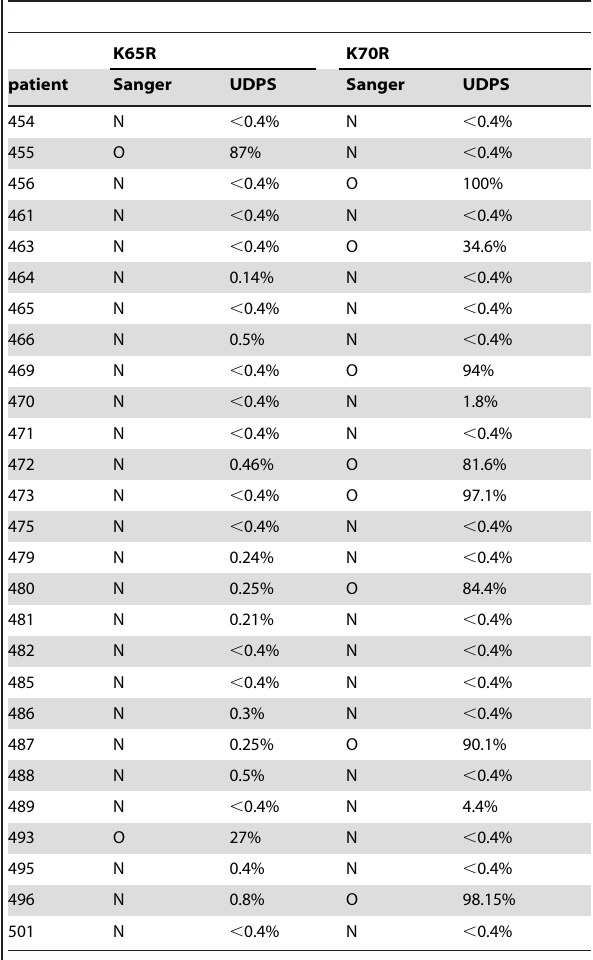
infection and therefore from potential transmission of K65R mutants. For us, this naı¨ve population was the basis of an evaluation of natural variation at codon 65 in subtype C HIV-1.